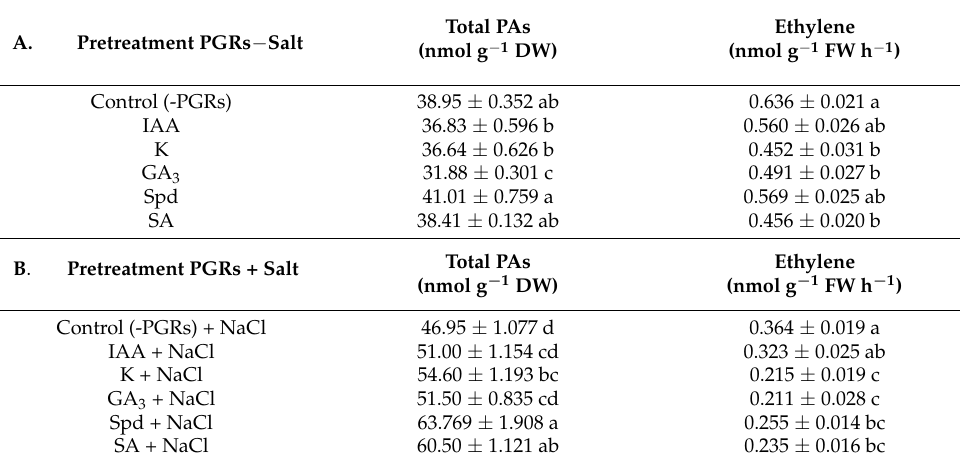
Table 4. ( A ). Effect of pretreatment PGRs − salt, and ( B ) PGRs + salt (300 mM NaCl) in F. pulverulenta leaves on total PAs and ethylene production. The values represent means ± SE ( n = 4). Different ( p ≤